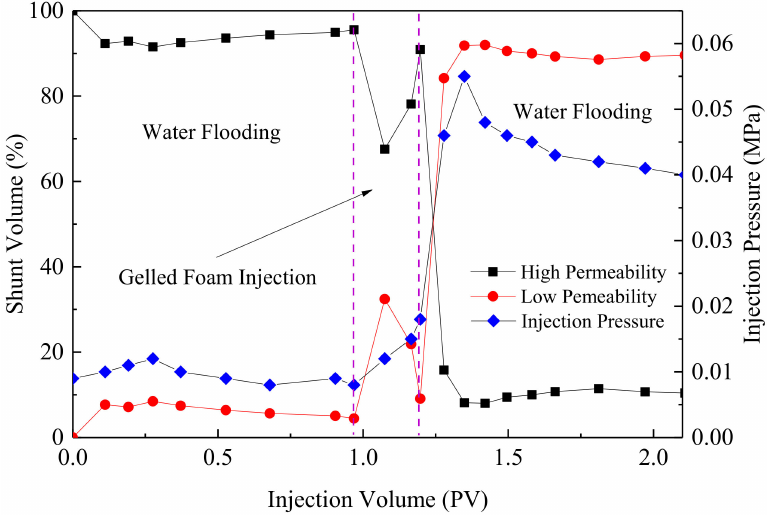
Figure 11. Injection pressure and outflow rate in the gelled foam profile control experiment.